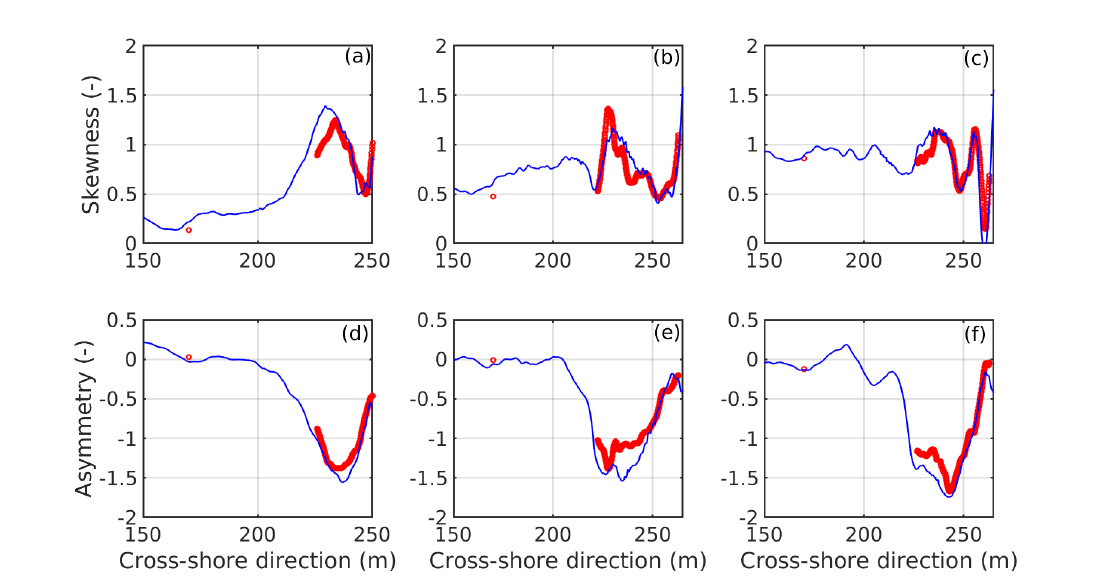
Figure 7. Cross-shore evolution of the computed (blue solid line) and observed (red circles) skewness S k and asymmetry A s for all cases. Values at WG2 are shown as circles at x = 170 m. ( a – c ): S k of cases DR0, SBE2, and SBA1. ( d – f ): A s of cases DR0, SBE2, and